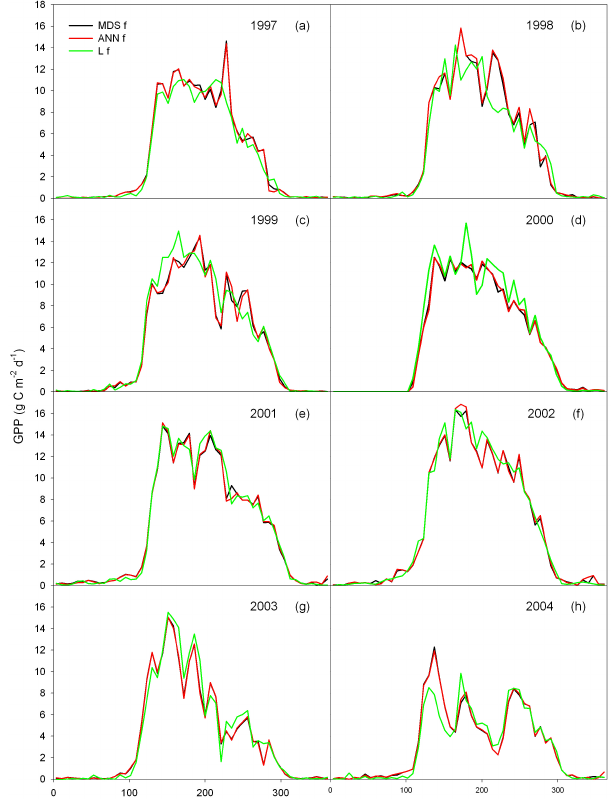
Fig. 3. Weekly values of gross primary production (GPP) for each of the 8 experimental years at the beech stand of Hesse derived from eddy covariance methodology and three flux processing meth- ods: (i) MDS f : footprint corrected, gapfilled with marginal distribu- tion sampling (MDS; Reichstein et al., 2005) and partitioned with short term air temperature regression (STATR; Reichstein et al., 2005); (ii) ANN f : footprint corrected, gapfilled with artificial neu- ral network (ANN; Papale et al., 2003) and partitioned with STATR and (iii) L f : footprint corrected, gapfilled and partitioned with the light-response curve model of Lasslop et al.